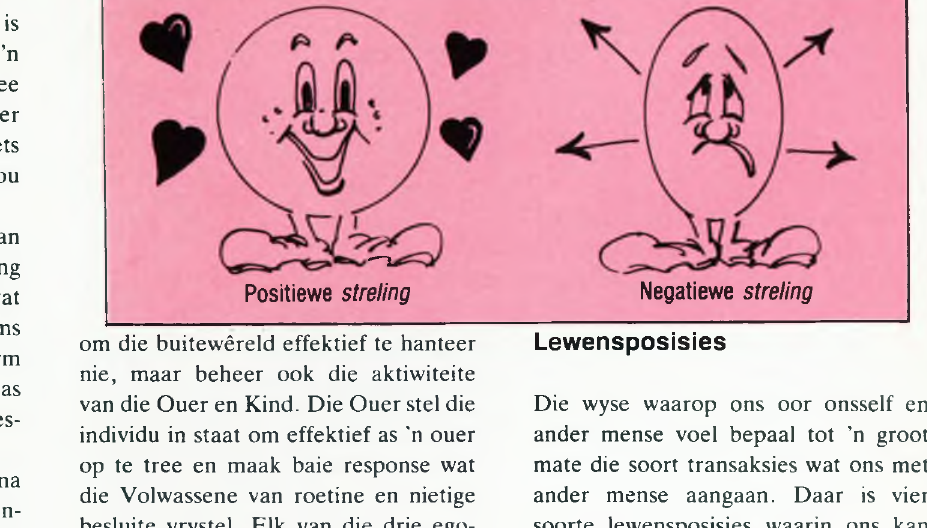
Figuur 6: Positiewe en negatiewe “strelings”